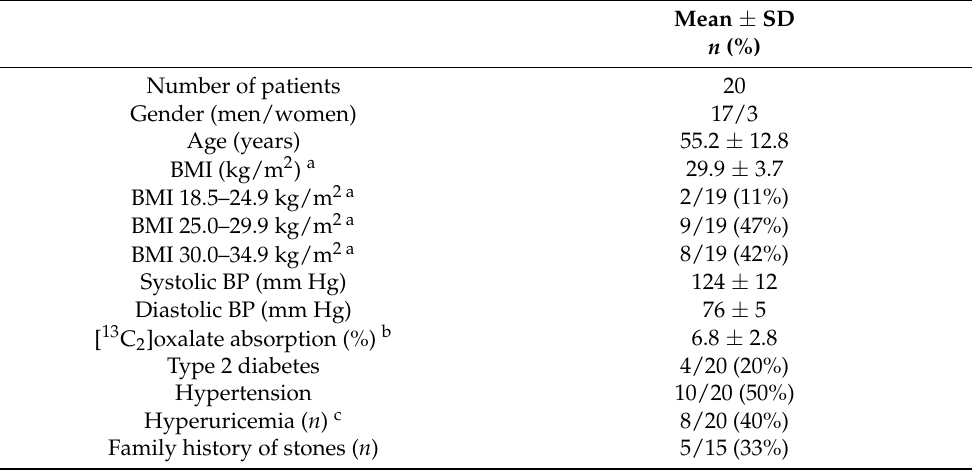
Table 1. Characteristics of uric acid stone patients.